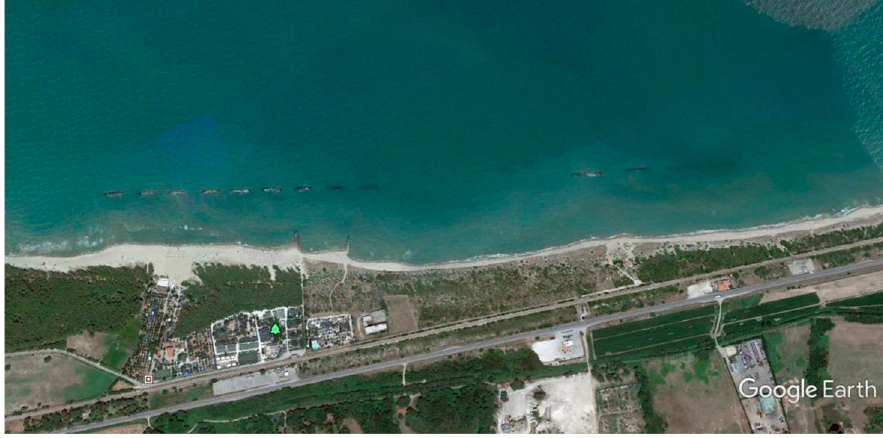
Figure 14. Shoreline planform at S E4 .